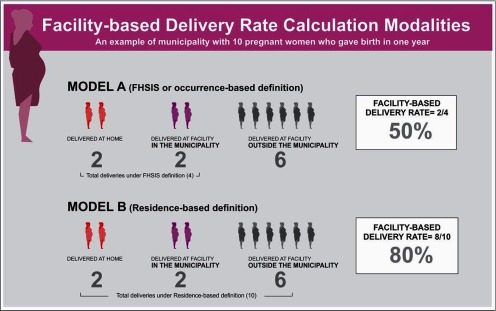
Comparison of Occurrence-Based With Residence-Based Computations of the Facility-Based Delivery RateAbbreviation: FHSIS, Field Health Services Information System.